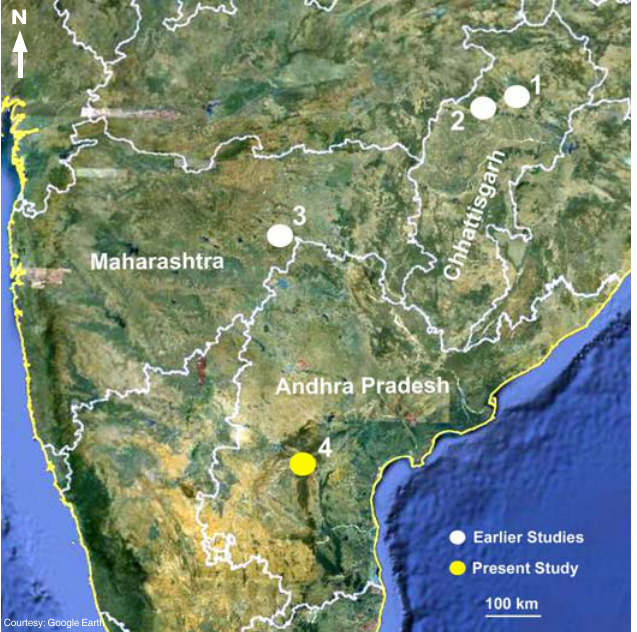
1. Satellite image showing distribution of Eutropis innotata (Blanford, 1870) in three Indian states viz., 1 - Korba (22 0 20’N & 82 0 41’E); 2 - Bilaspur (22 0 05’N & 82 0 09’E)